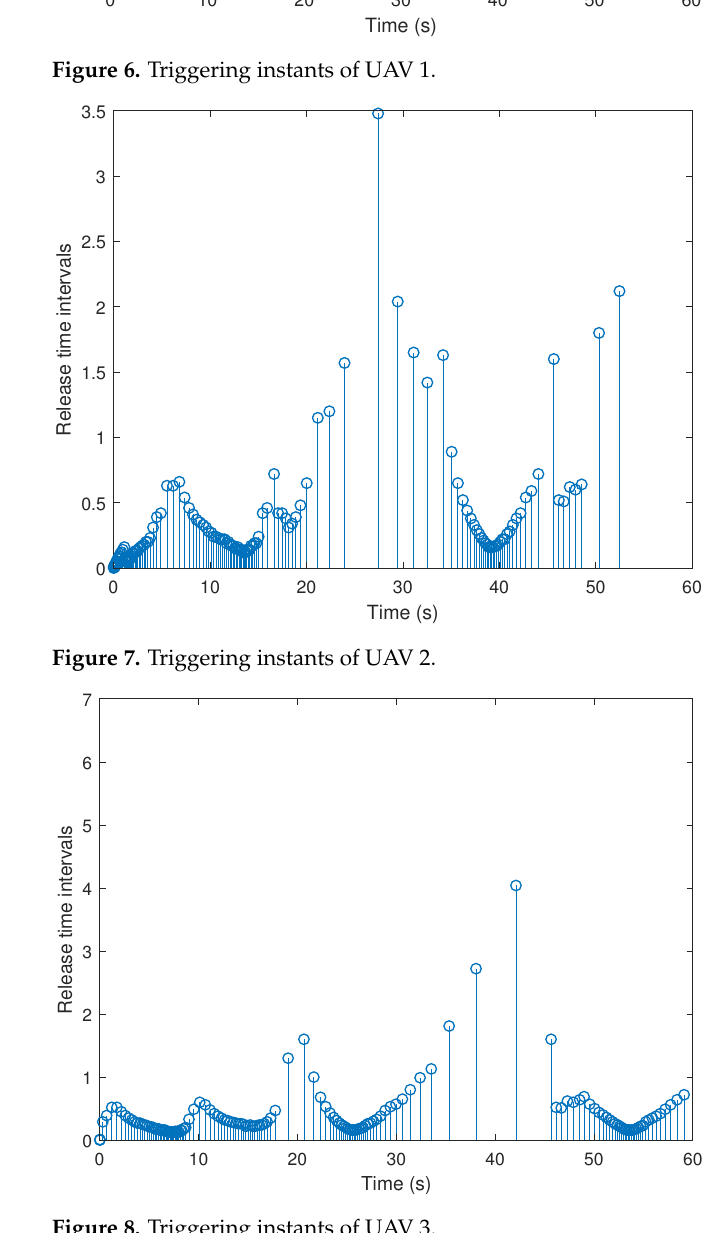
Figure 8. Triggering instants of UAV